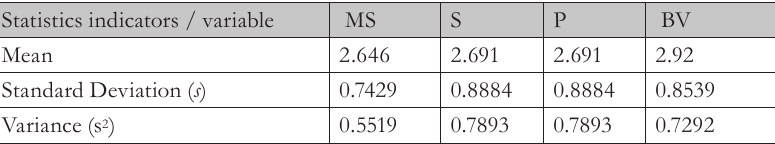
Tab. 4 – Statistical evaluation of the data file. Source: own research Statistics indicators /